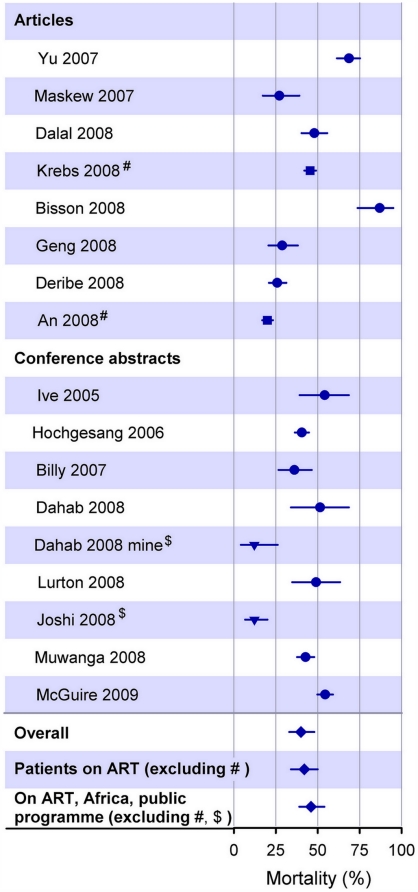
Mortality of patients LTFU that were successfully traced.Study-specific mortality estimates with binomial exact confidence intervals, combined estimates and confidence intervals from random effects meta-analysis. Studies including patients not on ART (# ; squares); workplace programme, programme from outside Africa ($ ; triangles).